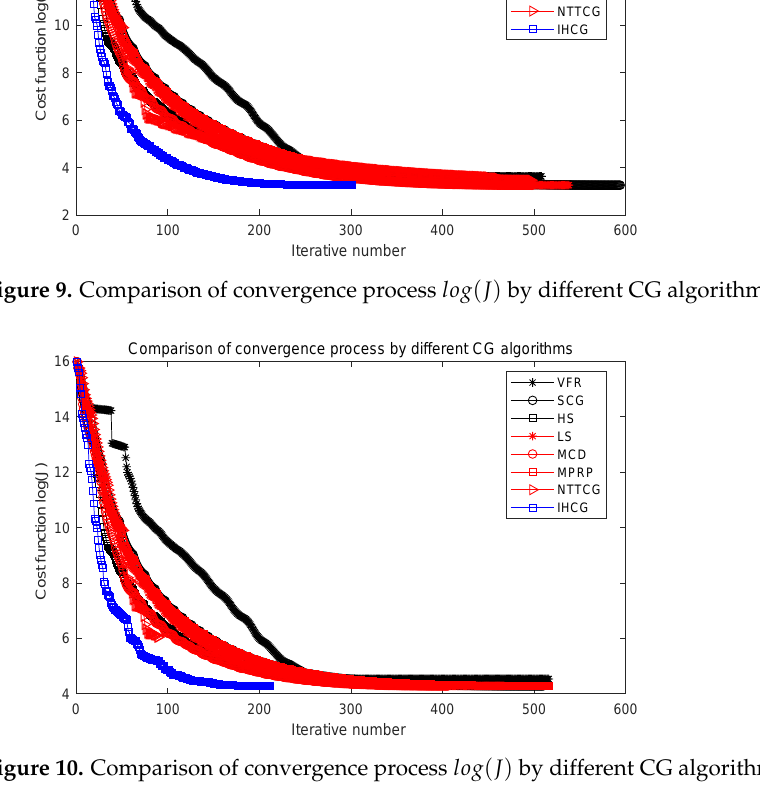
Figure 10. Comparison of convergence process log ( J ) by different CG algorithms ( δ =